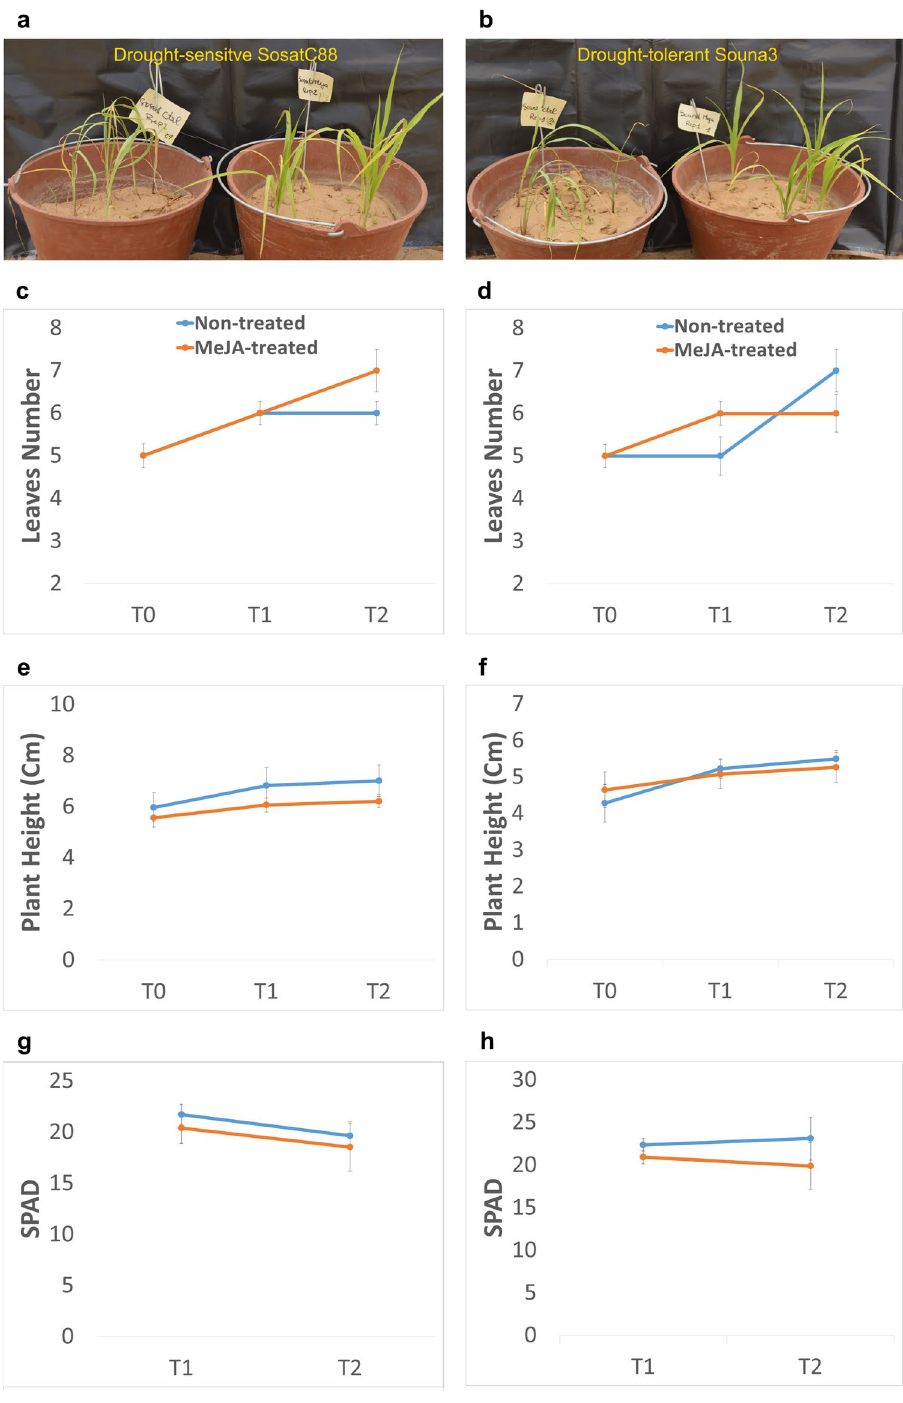
Figure 1. Effects of MeJA spraying on development and chlorophyll content of SosatC88 (left: non-treated; right: MeJA-treated) and Souna3 (left: non-treated; right: